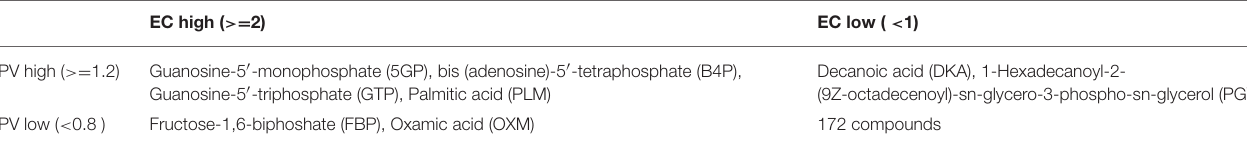
TABLE 2 | Compounds with extreme pocket variability (PV) and enzymatic target diversity (EC entropy) and combinations thereof. EC high ( > = 2) EC low ( < 1) PV high ( > = 1.2)